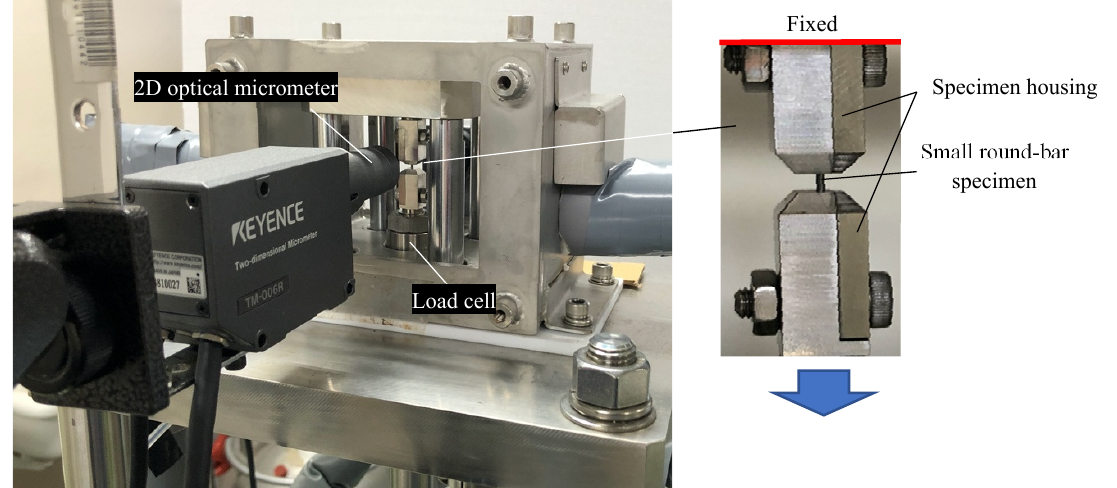
Figure 6. Tensile test machine for the small round-bar specimen.